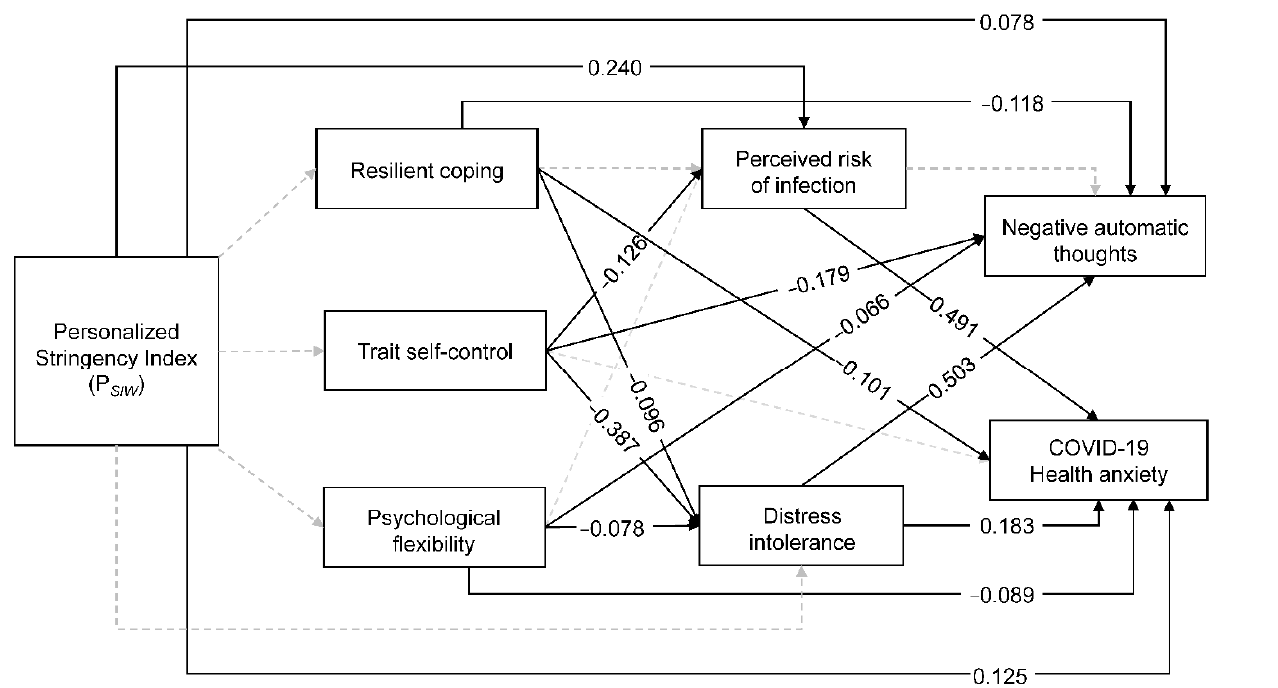
Figure 2. Results of the path model investigating effects of personalized stringency conditions (P SIW ) and protective psychological factors on COVID-19 related outcome variables: direct effects. Correlations between variables at the same levels (predictors, mediators, outcomes) were allowed, but are omitted in favor of clarity.